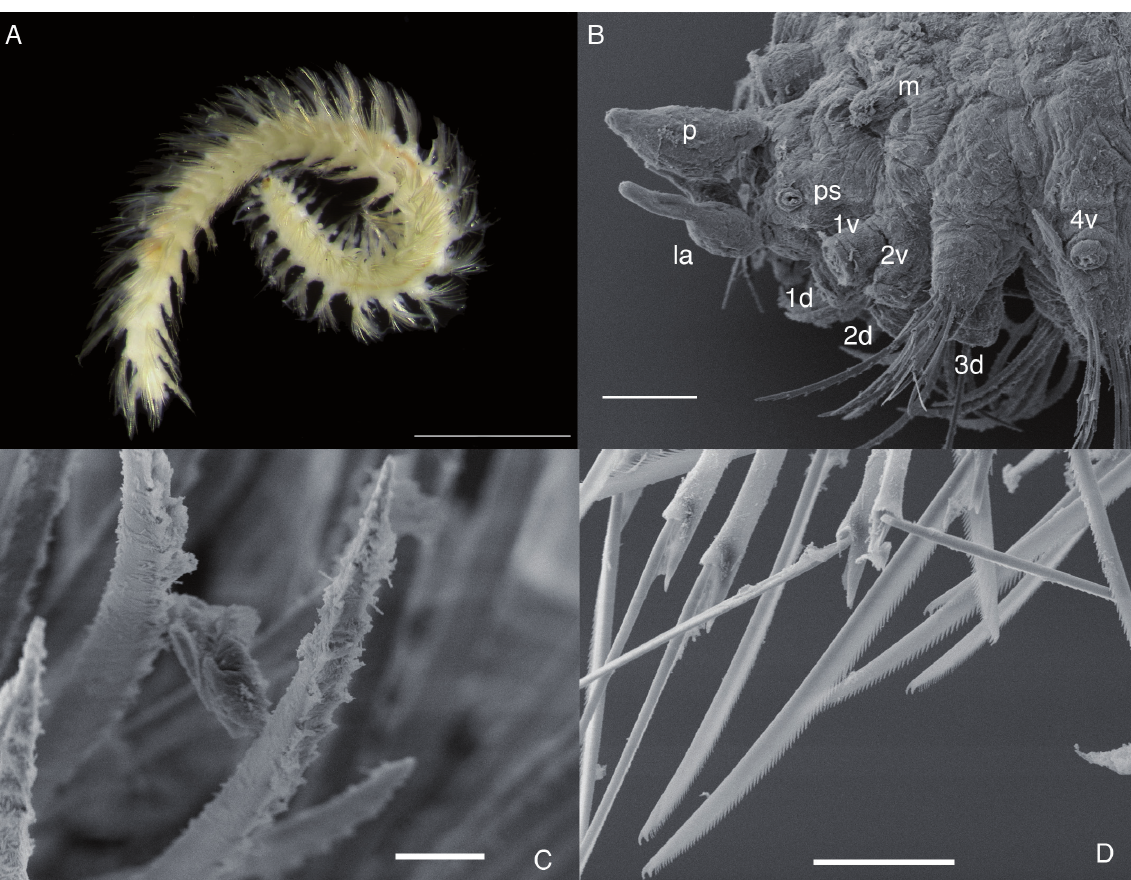
Fig. 2. Dysponetus joeli Olivier et al. , 2012. A. NMW.Z.2009.027.0003, whole specimen, dorsal view (scale bar 1 mm). B. NMW.Z.2009.027.0005, anterior end, ventrolateral view (scale bar 50 µm). C. Notochaetae (scale bar 10 µm). D. Neurochaetae (scale bar 20 µm). – d = dorsal (cirrophore), la = lateral antenna, m = mouth appendage, p = palp, ps = palp scar, v = ventral (cirrophore); numbers indicate the